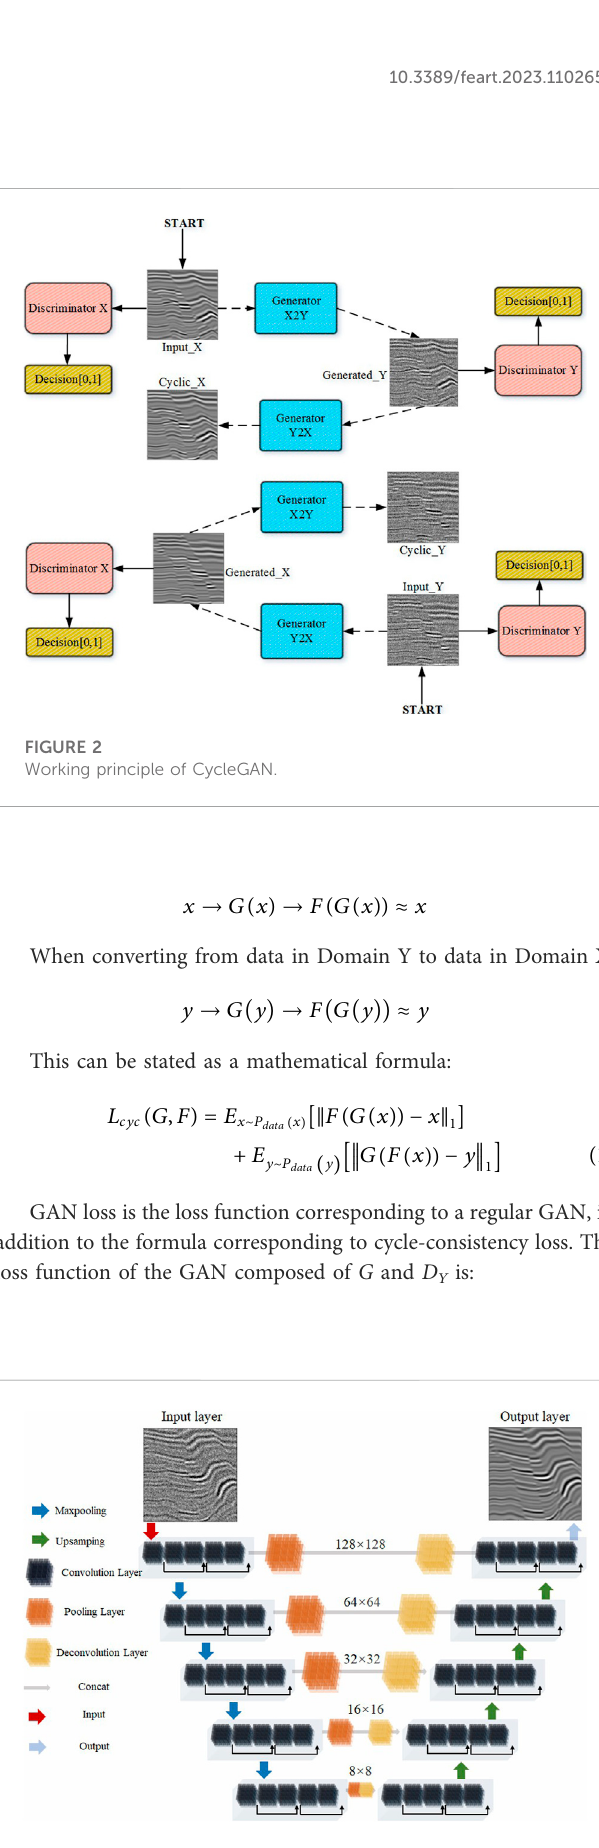
FIGURE 3 Improved CycleGAN generator network structure used in this study.